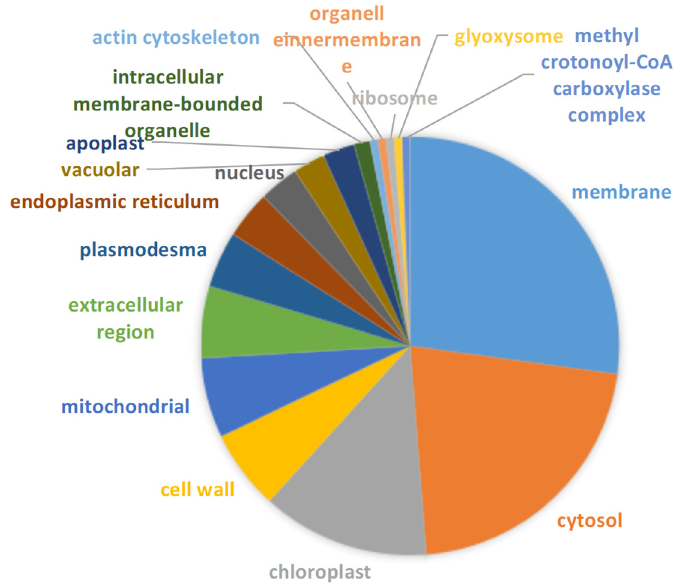
Figure 5. Subcellular localization of the DEPs under drought stress.